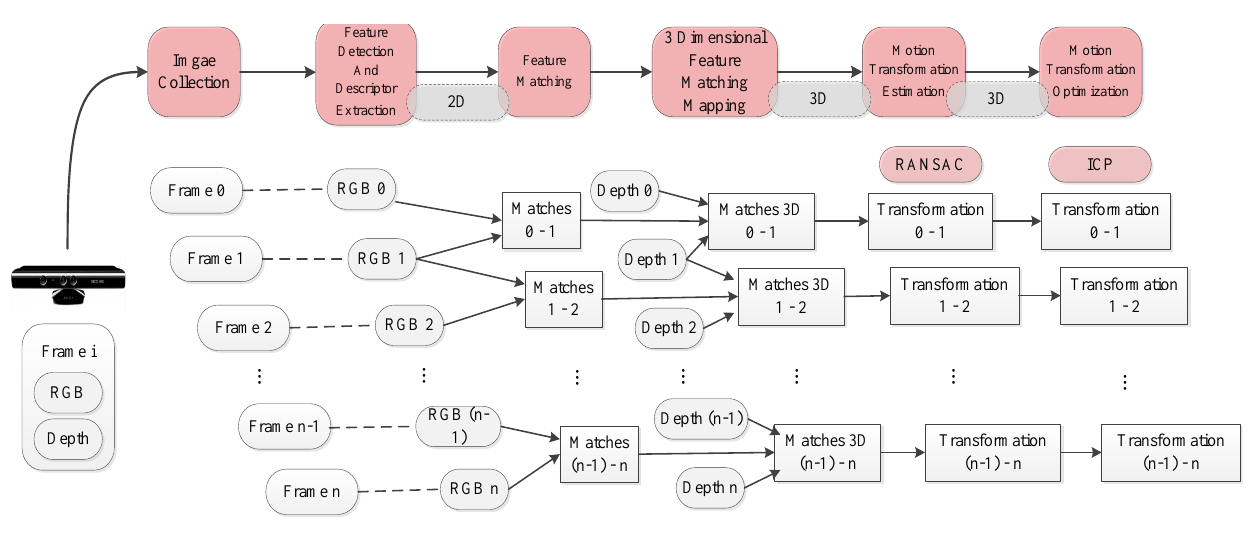
Figure 1. The sketch map for RGB-D SLAM algorithm in the front